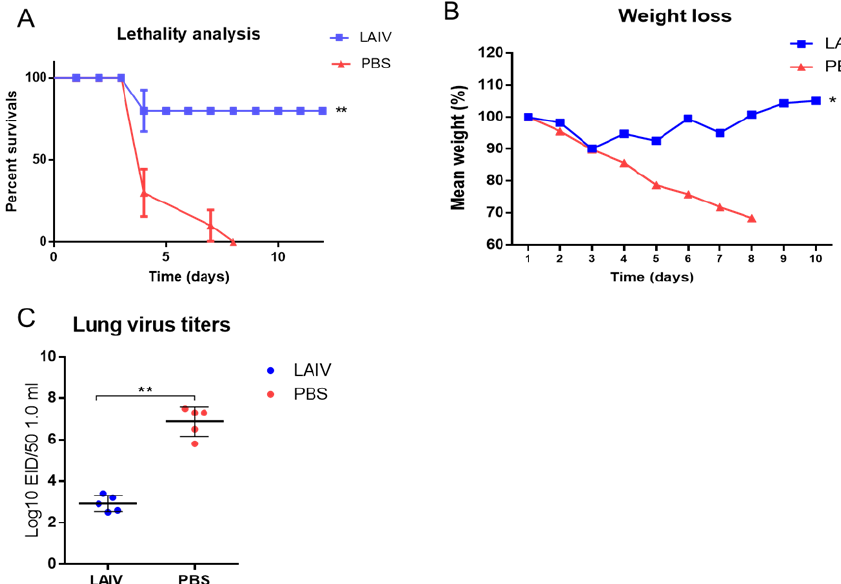
Figure 1. Challenge using 10 MLD50 of A/South Africa/3626/13(H1N1)pdm09 influenza virus